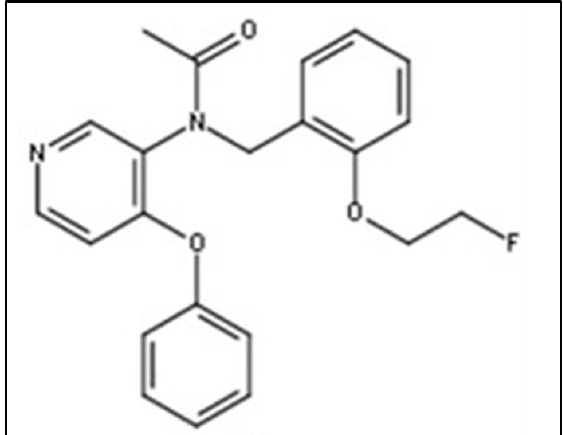
Figure 4. Chemical structure of (2-(2-(( N -4-phenoxypyridin-3-yl)acetamido)methyl)phenoxy)ethyl 4-methylbenzenesulfonate) radiolabeled with F-18 ([ 18 F]FEPPA) which belongs to the family of phenoxypyridinylacetamides.